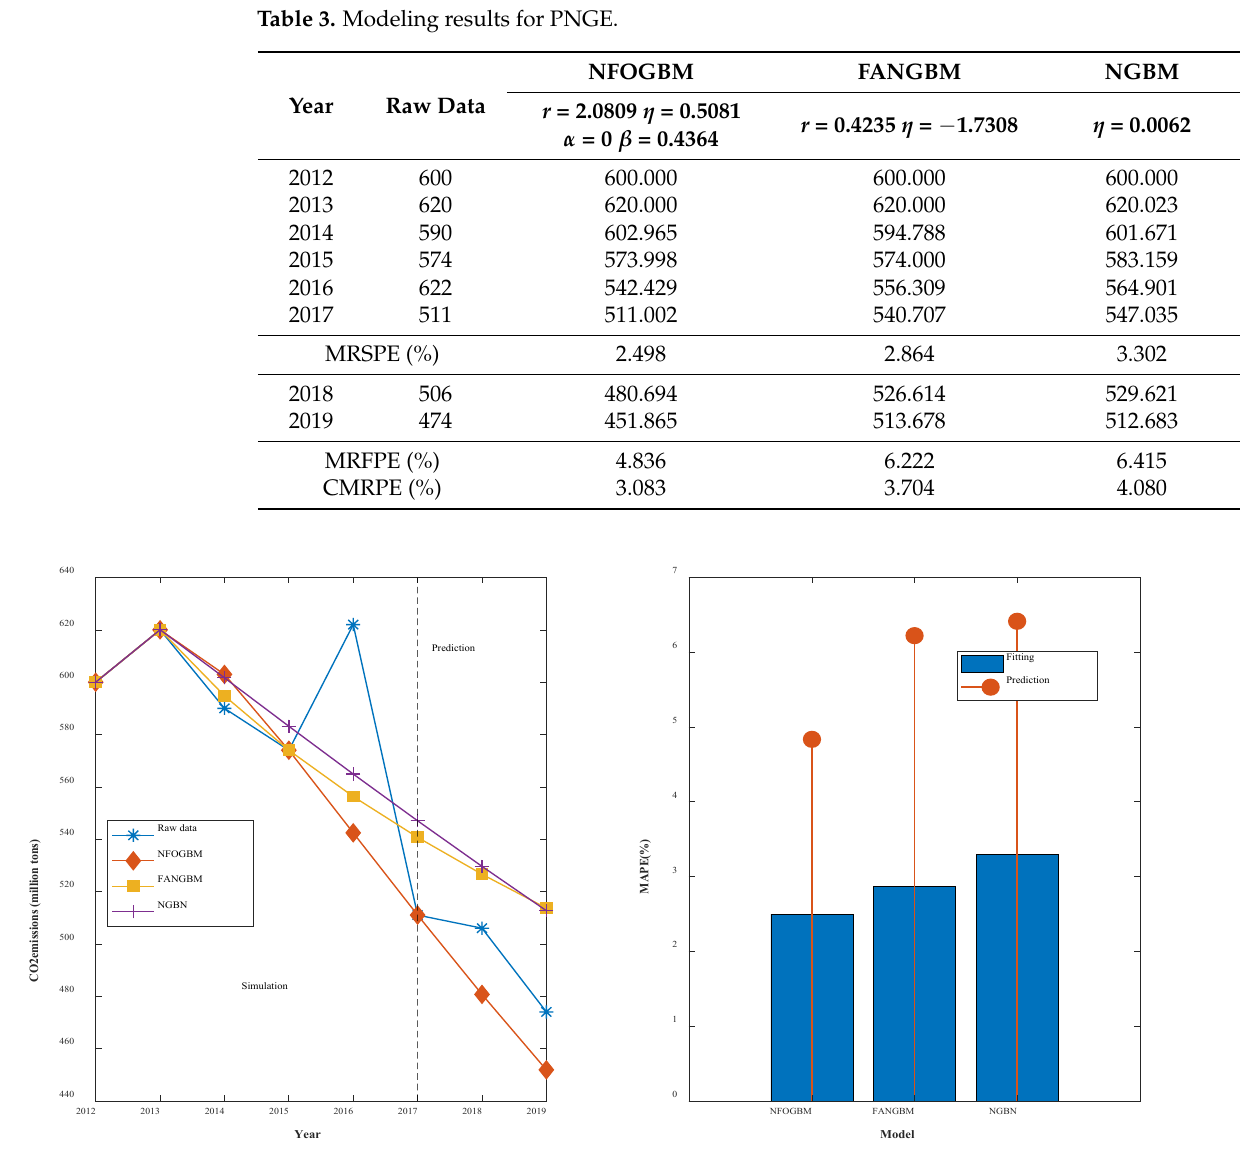
Table 3. Modeling results for PNGE.